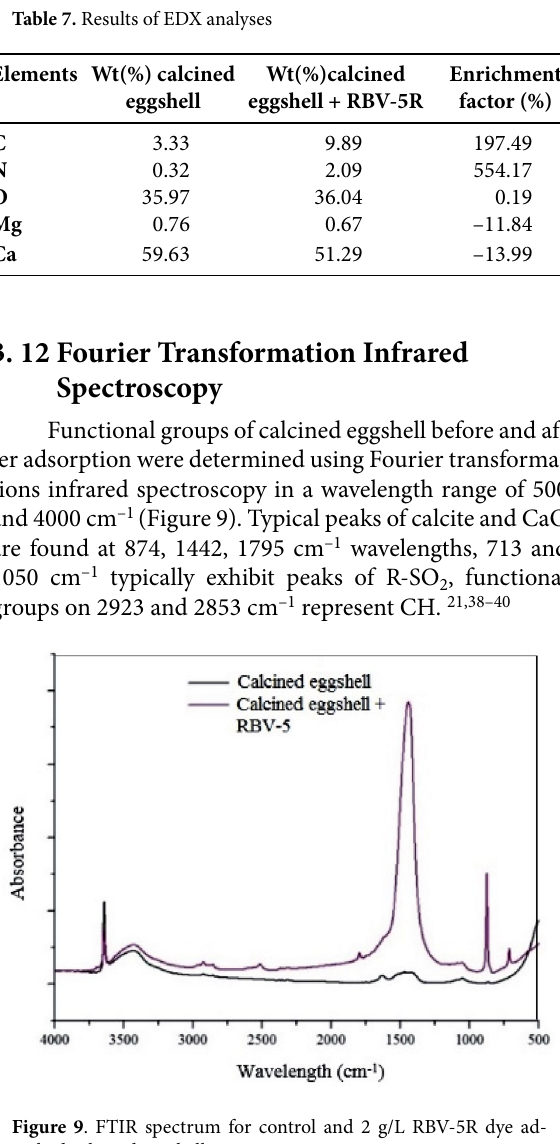
Figure 9 . FTIR spectrum for control and 2 g/L RBV-5R dye ad- sorbed calcined